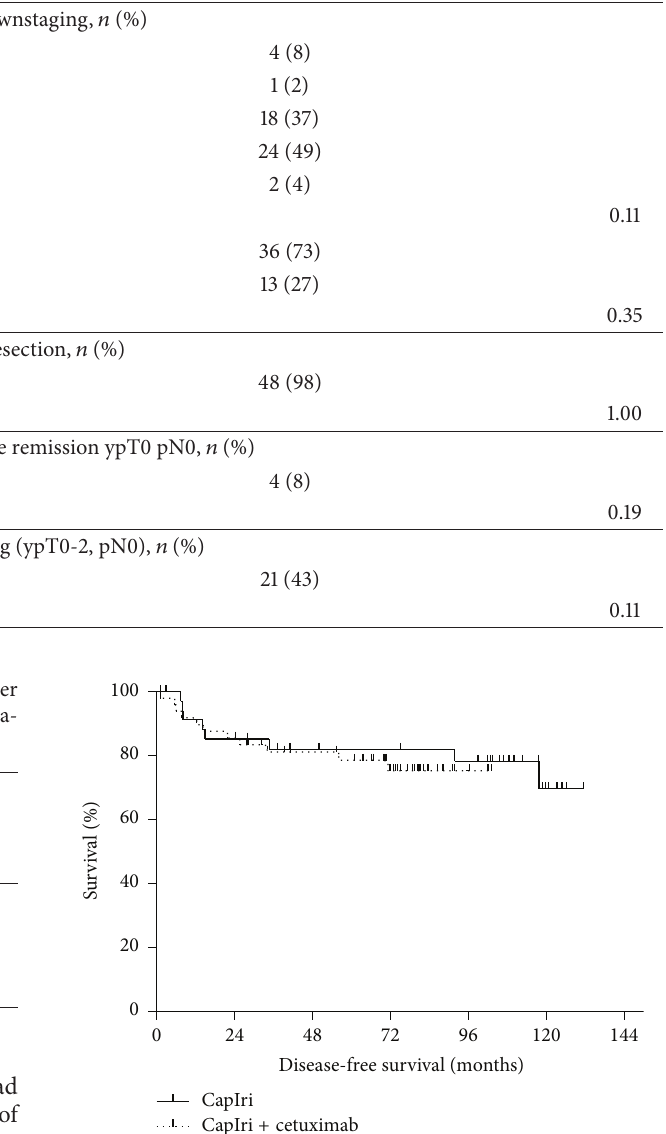
Figure 1: Disease-free survival of patients with locally advanced rectalcancerreceivingcapecitabine/irinotecan+/ − cetuximabbased chemoradiotherapy as preoperative treatment ( 𝑛 = 86 ). Shown are survival curves of patients treated with CapIri (solid curve; 𝑛 = 37 ) versus patients treated with CapIri + cetuximab (dotted curve; 𝑛 = 49 ), 𝑃 = 0.62